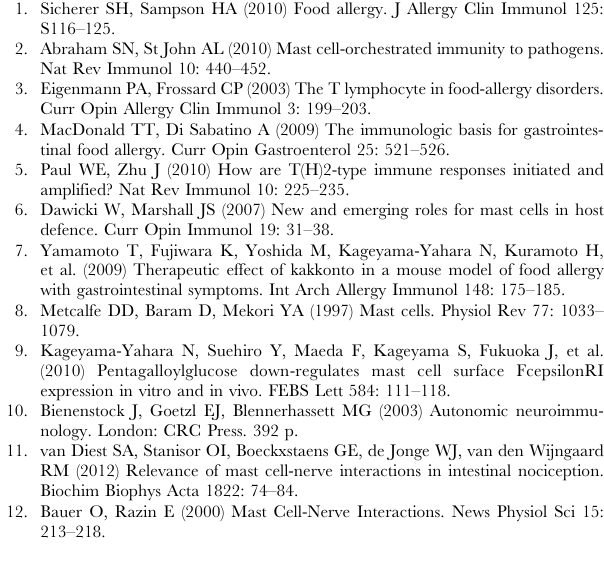
Figure S1 a 7 nAChR-mediated control of food allergy in mice. The occurrence of allergic diarrhea in FA mice (closed circle), GTS-21-treated mice (open circle; 10 mg/kg, p.o.) and MLA-treated mice prior to GTS-21 administration (open square; 1 mg/kg, s.c.) after each oral OVA challenge is shown. * P ,